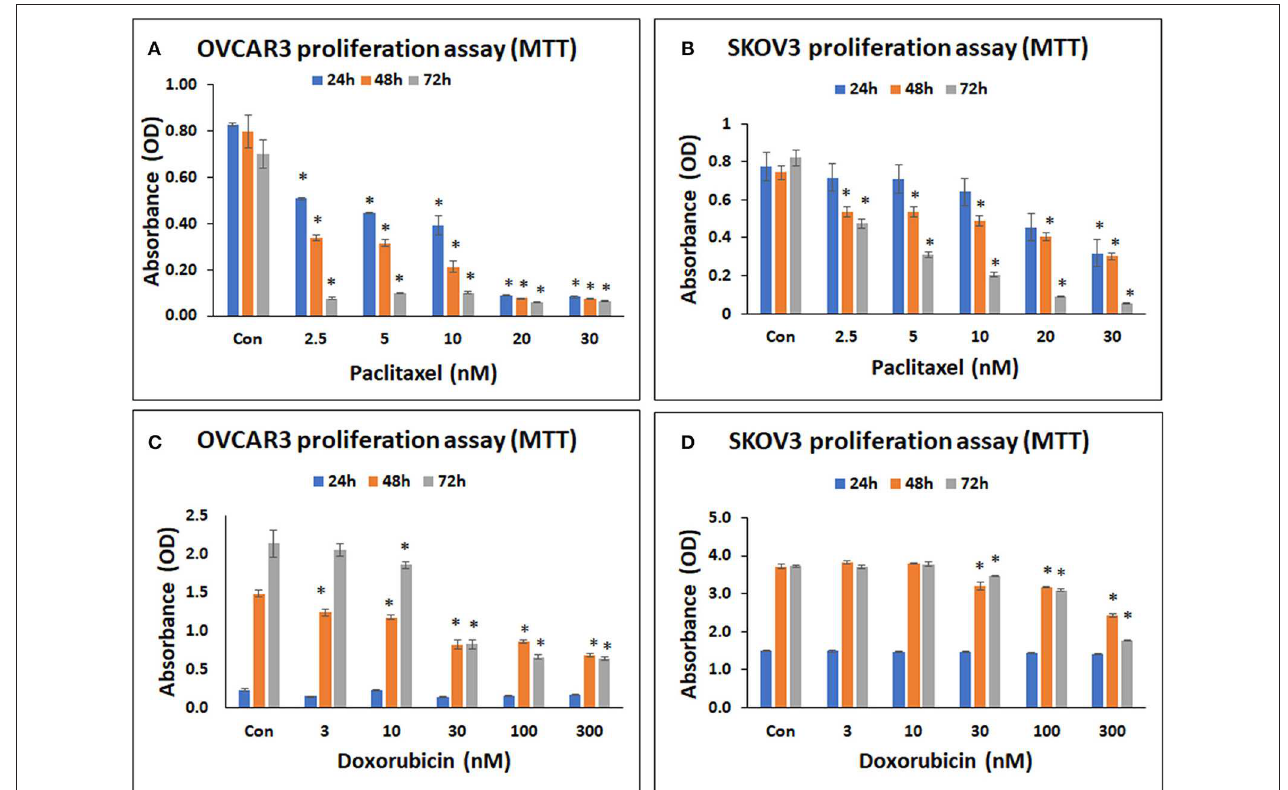
FIGURE 3 | Cell metabolic activity assay of OVCAR3 cells treated with paclitaxel (A) ; SKOV3 cells treated with paclitaxel (B) ; OVCAR3 cells treated with doxorubicin (C) and SKOV3 cells treated with doxorubicin (D) . The standard anticancer agents (paclitaxel and doxorubicin) demonstrated significant inhibition in both OVCAR3 and SKOV3 cell metabolic activity with increasing drug concentrations and time. The values are expressed as mean ± SEM of three different experiments. *indicates statistical significance ( p < 0.05) compared to the control.